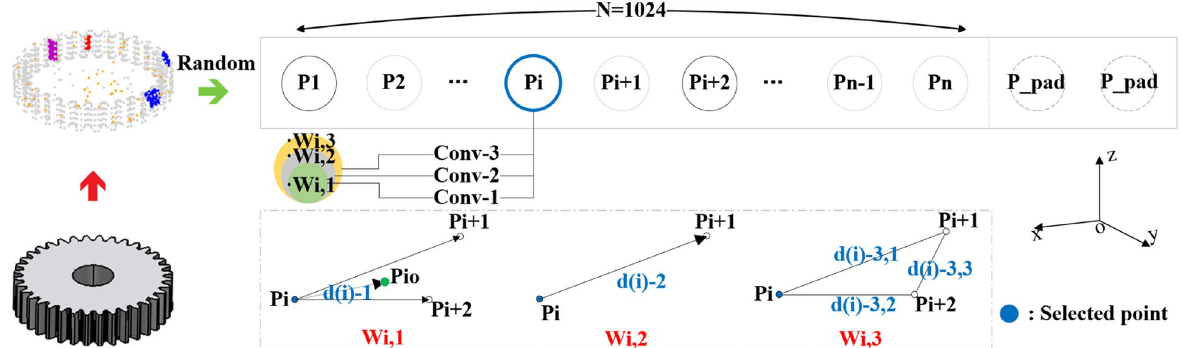
Fig. 5 Feature weights optimization based on distance. Conv i is the convolution with kernel size i . W i , j is the weight of the i -th point and j represents the size of kernel